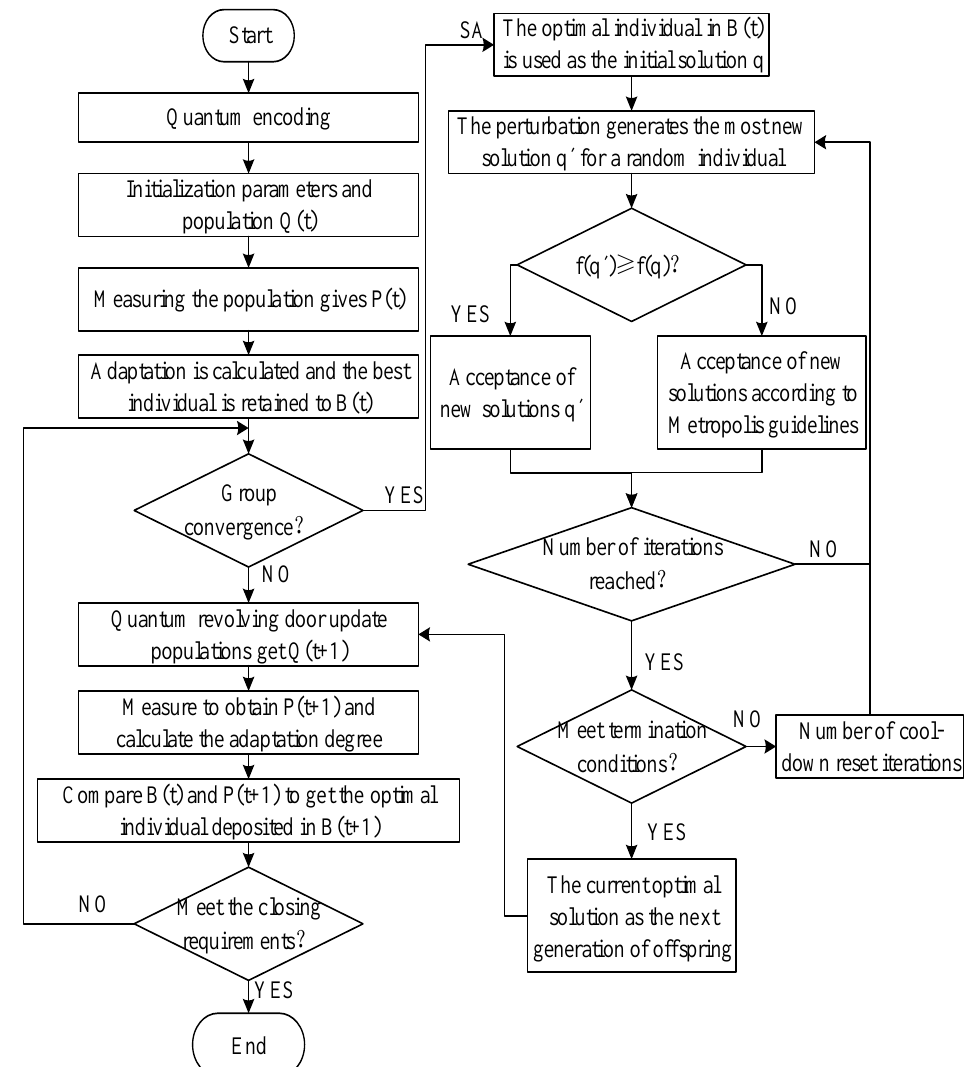
Figure 4. Flowchart of improved hybrid quantum genetic algorithm.